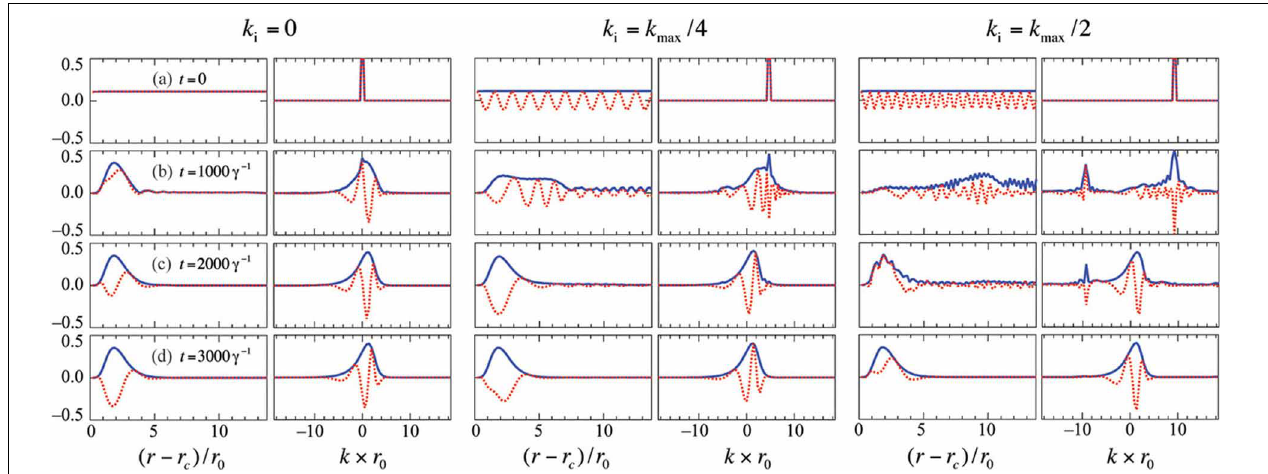
wavefunctions in the position and momentum representation for different initial relative momenta: k i = 0 (left); k i = k max / 4 (middle); and k i = k max / 2 (right), with k max = 18 . 5 / r 0 . The cutoff radius r c = r 0 .